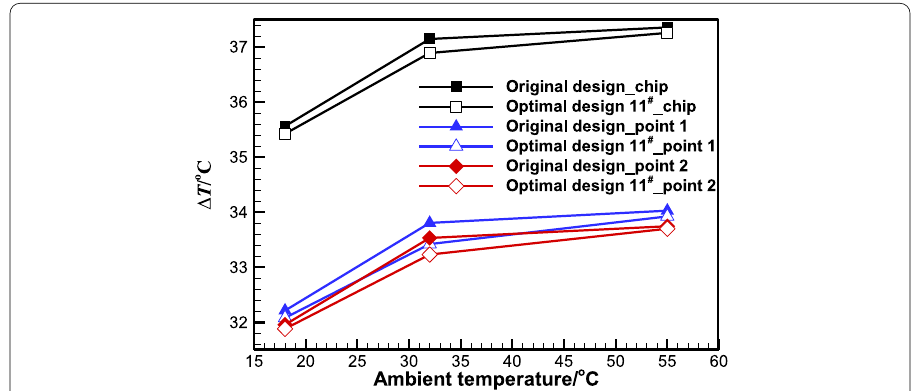
Fig. 13 Comparison of the temperature rise of the chip and at two measurement points under three ambient temperatures of 18 °C, 32 °C, and 55